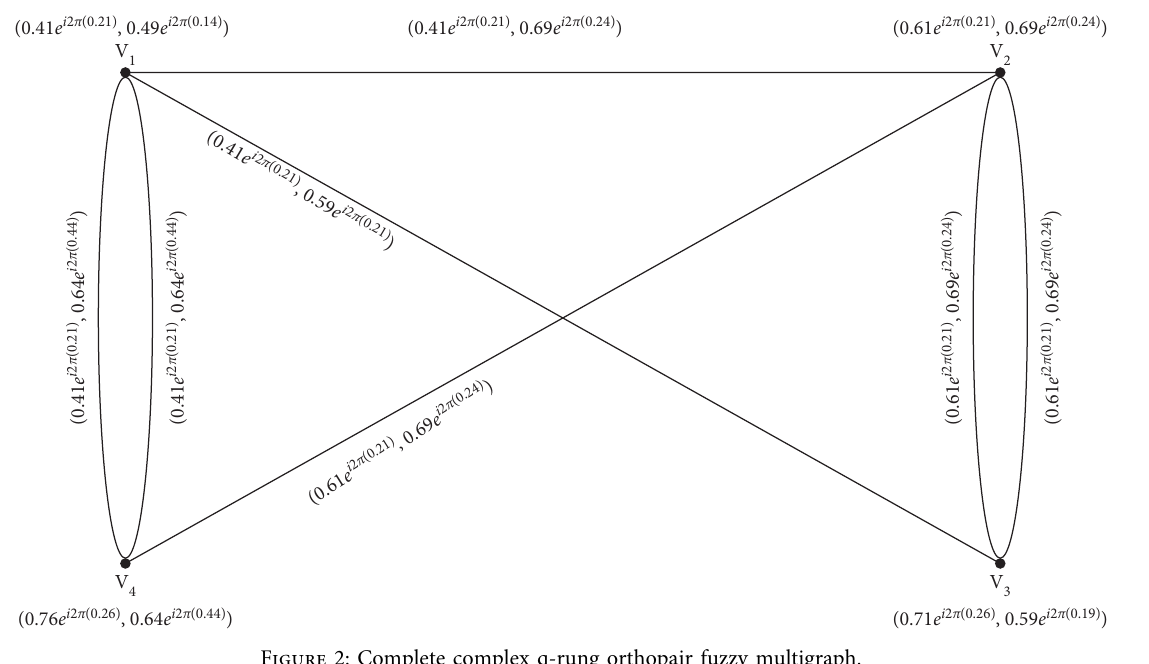
Figure 2: Complete complex q-rung orthopair fuzzy